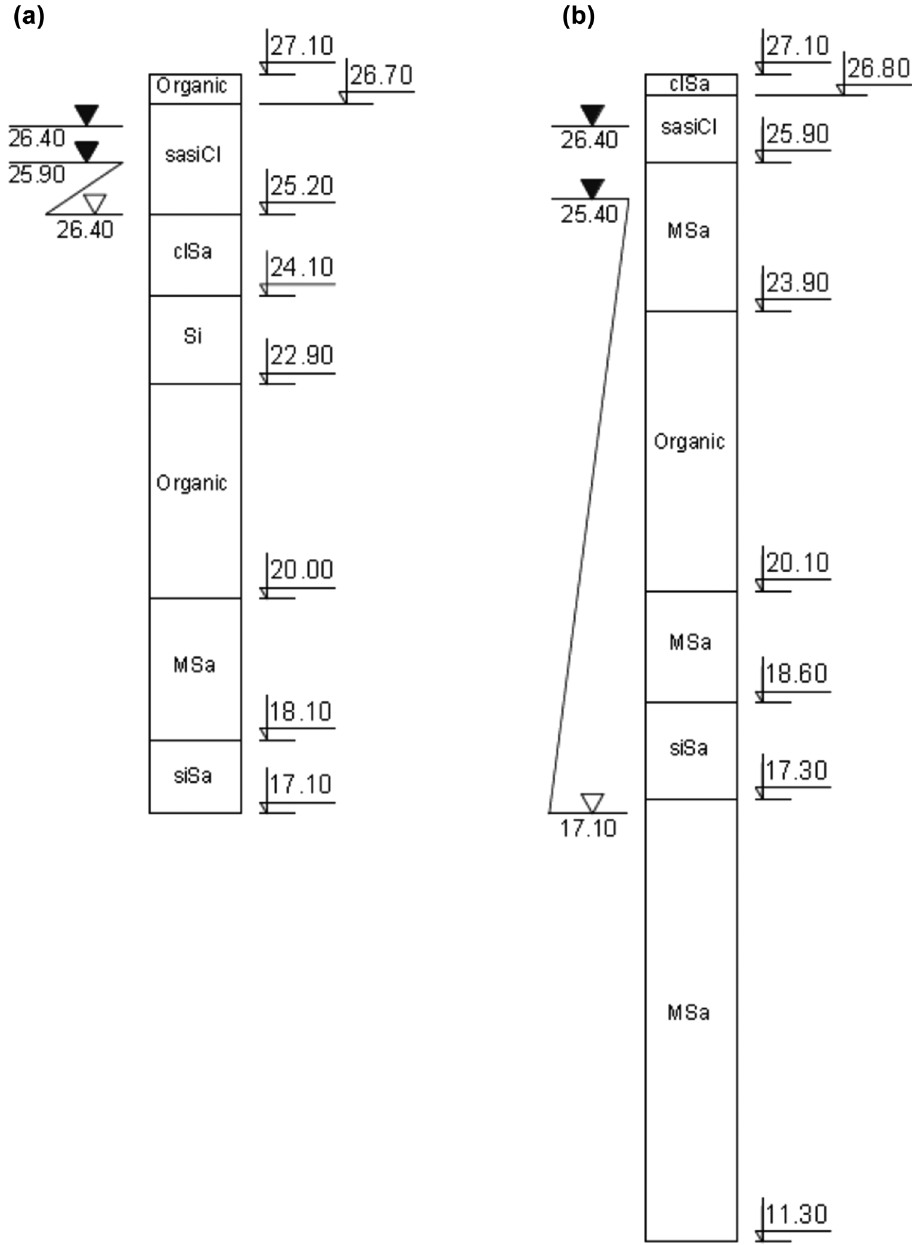
Figure 2: Geological pro fi le ( a ) from the project documentation ( b ) from supplementary tests for the SD